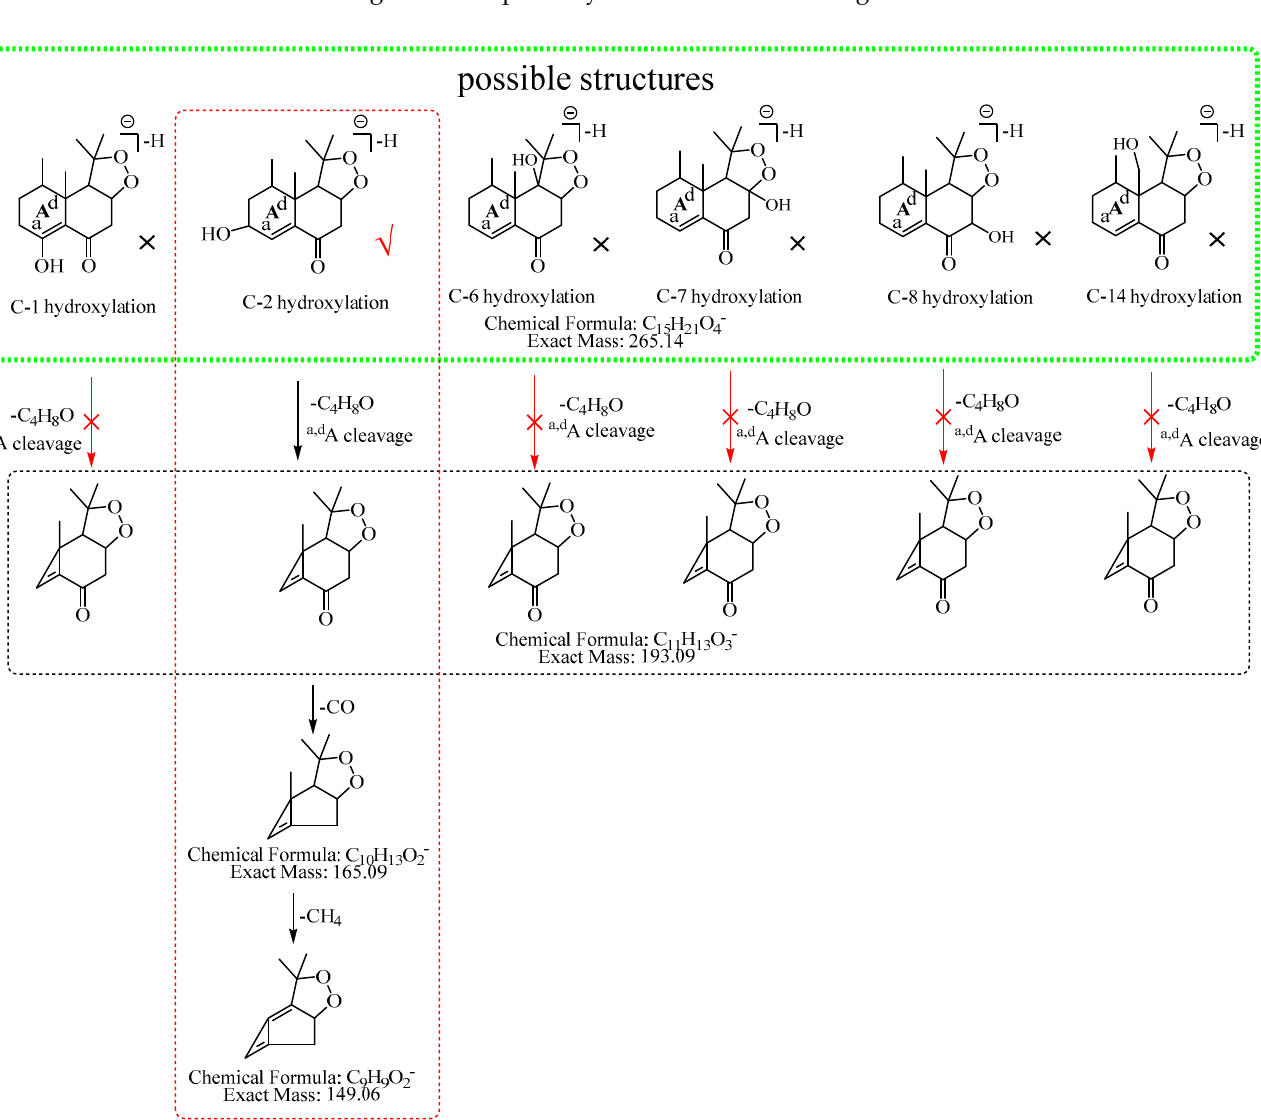
Figure 4. The proposed fragmentation pathways of M2 (2-hydroxyl nardosinone). “ √ ” represents the possible structure. “×” represents the impossible structure. The green rim represents the possible structures; A represents the hexatomic ring. The red rim represents the most possible fragmentation pathway.